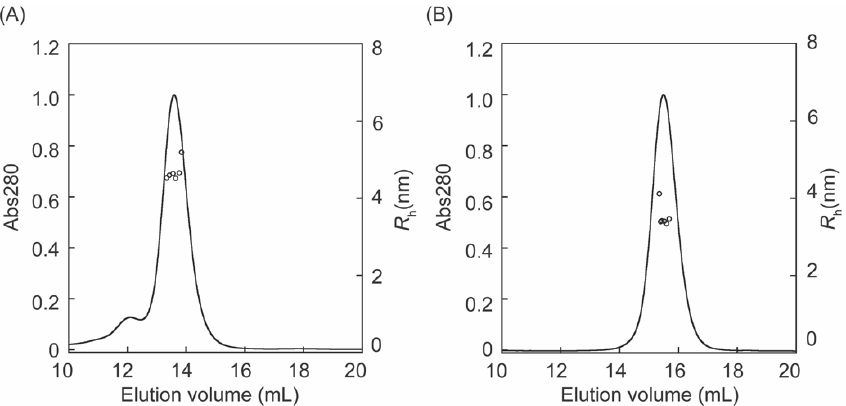
Figure 6. Hydrodynamic radii (R h ) of fl-LOXL2: ( A ) Δ 1-2SRCR-LOXL2 ( B ) calculated from SEC- MALS analysis.